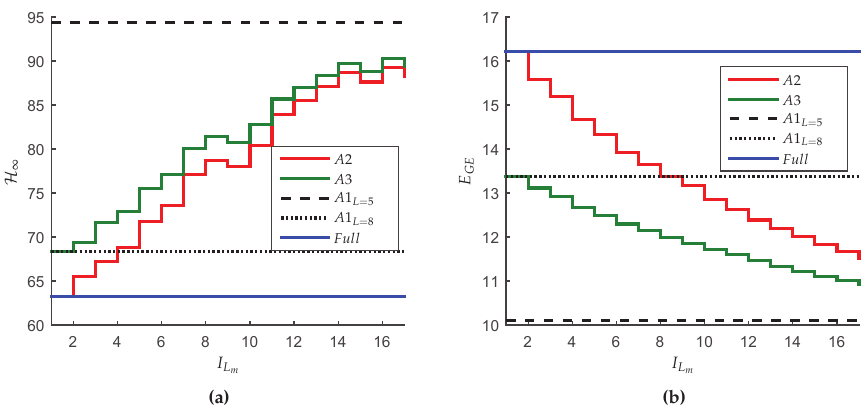
norm of the closed-loop system and ( b ) The global energy consumption ( E GE ) of the Figure 9. ( a ) H ∞ network using: the classical approach assuming a full-reliable ( L = ∞ ) network (in blue); A 1 with L = 5 ( A 1 L = 5 in dashed black); A 1 with L = 8 ( A 1 L = 8 in dotted black); A 2 with L 8,5 ( A 3 in A 3 with L ∈ { }